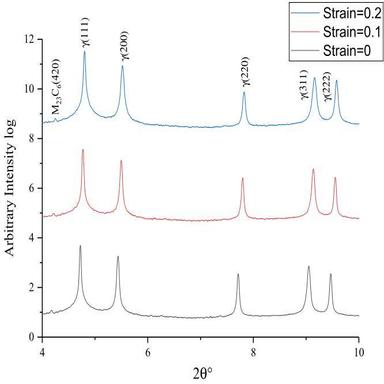
In situ X-ray diffraction spectra of Alloy 709 in logarithm scale intensity, respectively at engineering strains of 0, 0.1, and 0.2 showing the absence of martensite phase transformation.